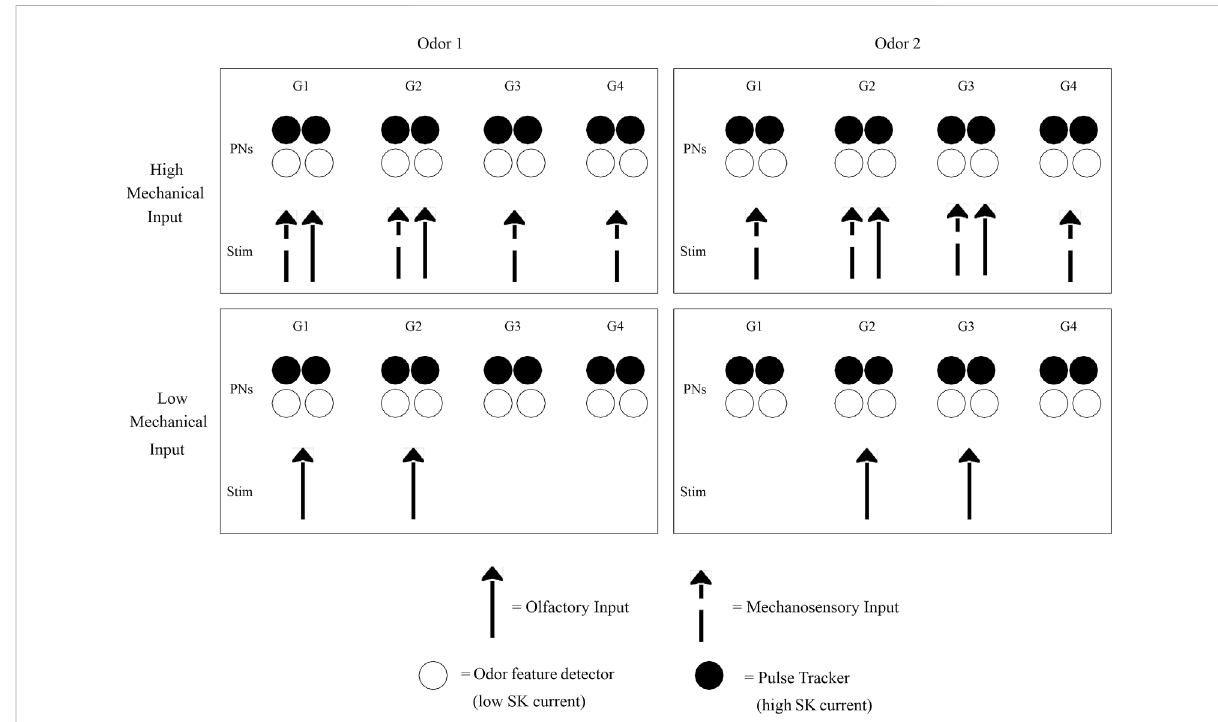
FIGURE 3 Schematic of bimodal stimulus encoding. The four glomeruli shown (G1, G2, G3, G4) each contain some PNs specialized for encoding odor features (possibly due to having weak intrinsic SK currents) and some PNs specialized for tracking the temporal dynamics of pulsatile odor encounters(possibly due to having strong SKcurrents).Different odors activate different glomerular subsets, while accompanying mechanosensory input has a diffuse glomerular activation pattern independent of odor identity. High Mechanical Input: This occurs, for example, during mid- fl ight odor-tracking, and yields the odor tracking dynamic regime. Glomeruli receiving strong olfactory input are responsible for encoding odor features, and their feature detecting PNs are the functionally relevant entities, while glomeruli receiving mechanosensory input but little olfactory input are responsible for tracking odor pulse dynamics, with their pulse tracking PNs playing the most prominent role. Since each glomerulus contains both types of PNs, every glomerulus is capable of both tasks (feature detecting and pulse tracking); the functional role a glomerulus plays depends onwhetherornot itisactivated bytheparticular odorthat isencountered.LowMechanicalInput:This occurs,for example,whenhovering near a fl ower, and yields the odor discrimination dynamic regime. Pulse tracking is less important while odor discrimination is the more immediate concern, and feature detecting PNs within glomeruli activated by the encountered odor(s) play the most prominent functional